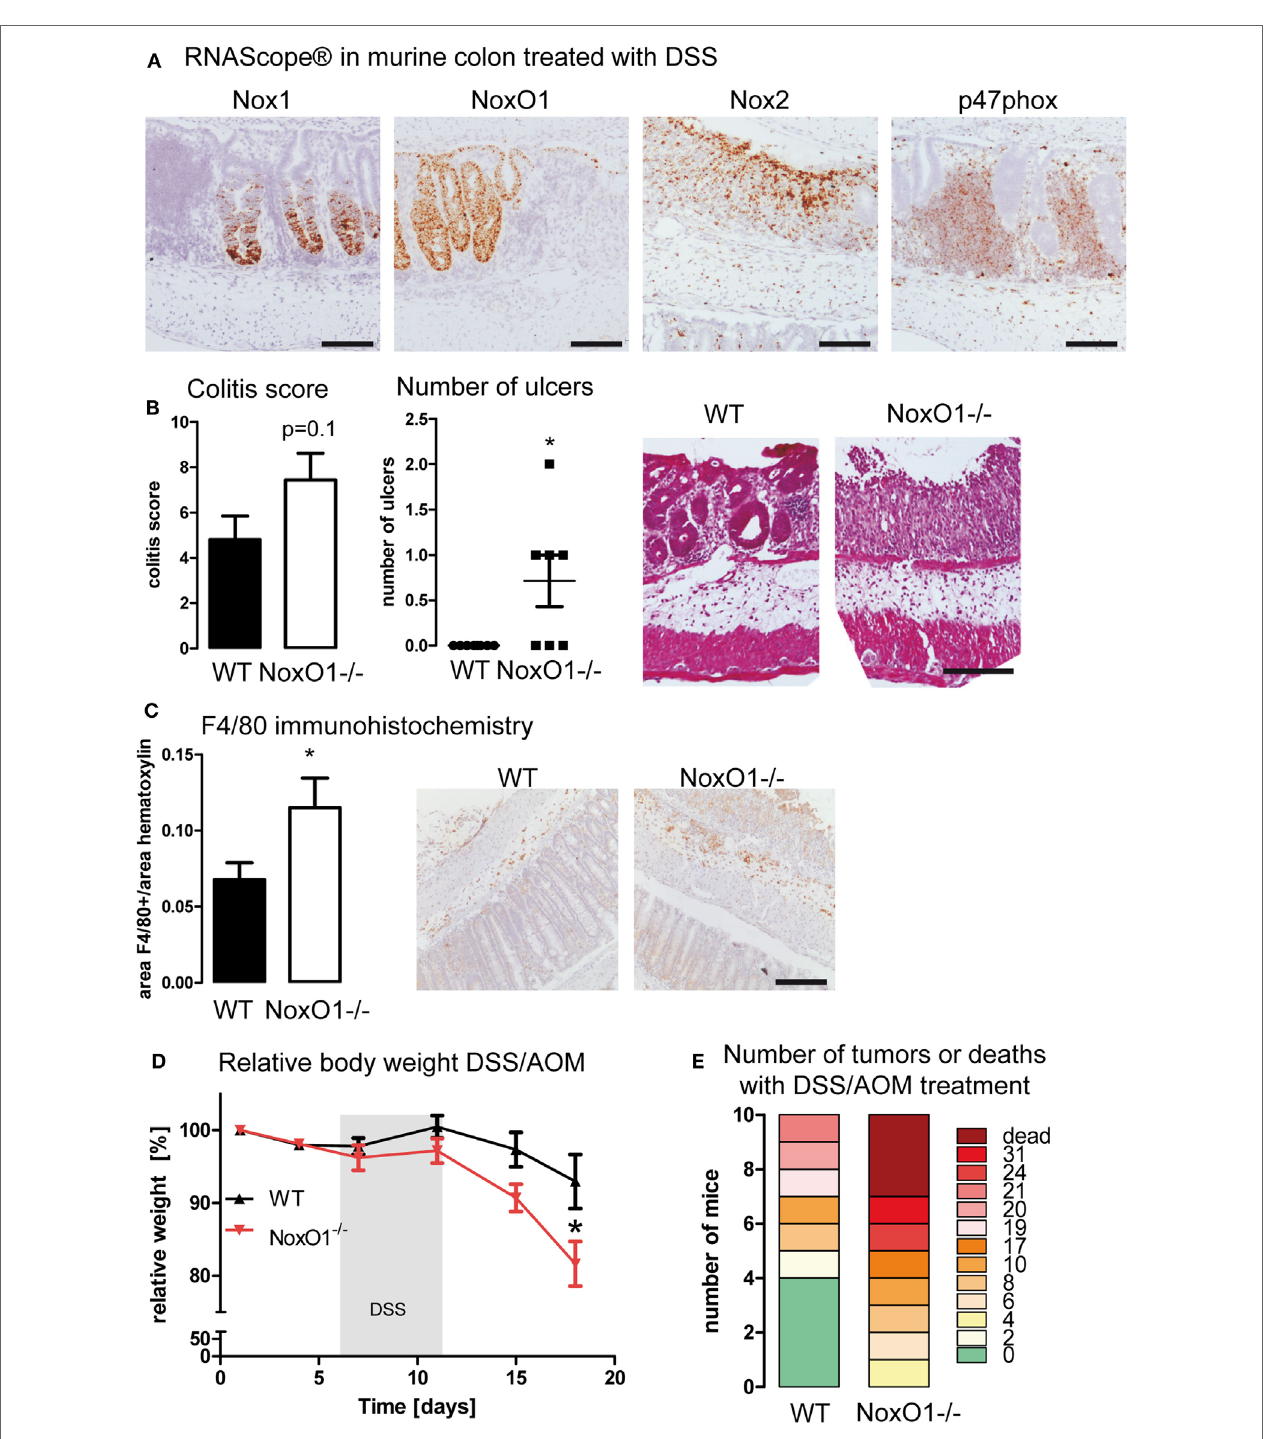
FigUre 5 | NoxO1 has a protective role in dextran sulfate sodium (DSS)-induced colitis and DSS/azoxymethane (AOM) colon carcinoma. (a) In situ hybridization (RNAScope ® ) showing the expression of Nox1, NoxO1, Nox2, and p47phox in murine colon tissue upon treatment with DSS. Nuclei were counterstained with hematoxylin, scale bars indicate 100 μ m. (B) Quantification of histological damage and number of ulcers on day 8 of the colitis model. n = 7–8, * p < 0,05, Mann–Whitney exact test. Representative pictures of hematoxylin and eosin (H&E) staining for wild-type (WT) and NoxO1 − / − are shown. Scale bar indicates 200 μ m. (c) Immunohistochemistry staining of macrophage marker F4/80. Representative pictures and analysis of F4/80-positive staining per nuclei. n = 7–8, * p < 0.05. Scale bars indicate 500 μ m. (D) Body weight relative to day 0 of WT and NoxO1 − / − mice treated with AOM at day 0 and 3 cycles of DSS in drinking water. n = 9, * p < 0.05. (e) Tumor burden at day 70 of DSS/AOM-treated animals. n =